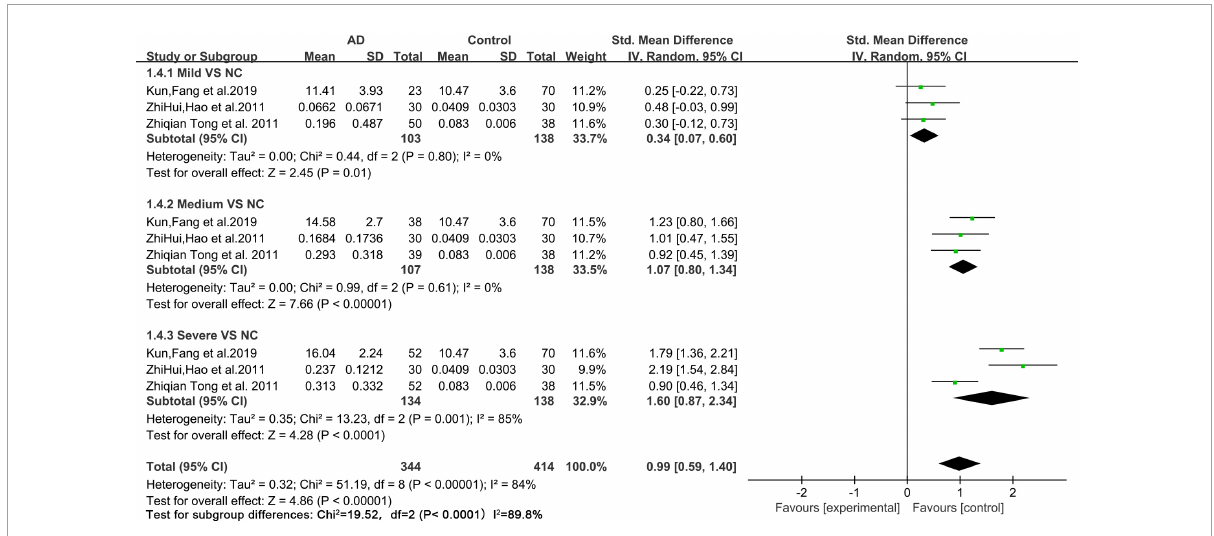
FIGURE5 Forest plot of a random effects meta-analysis of urine FA levels and degrees of AD (mild, medium, and severe) ( p < 0.0001). Diamonds represent combined effect estimates. The size of the green box is proportional to the weight assigned to each study, with horizontal lines representing 95% CI. SD, standard deviation; AD, Alzheimer’s disease.